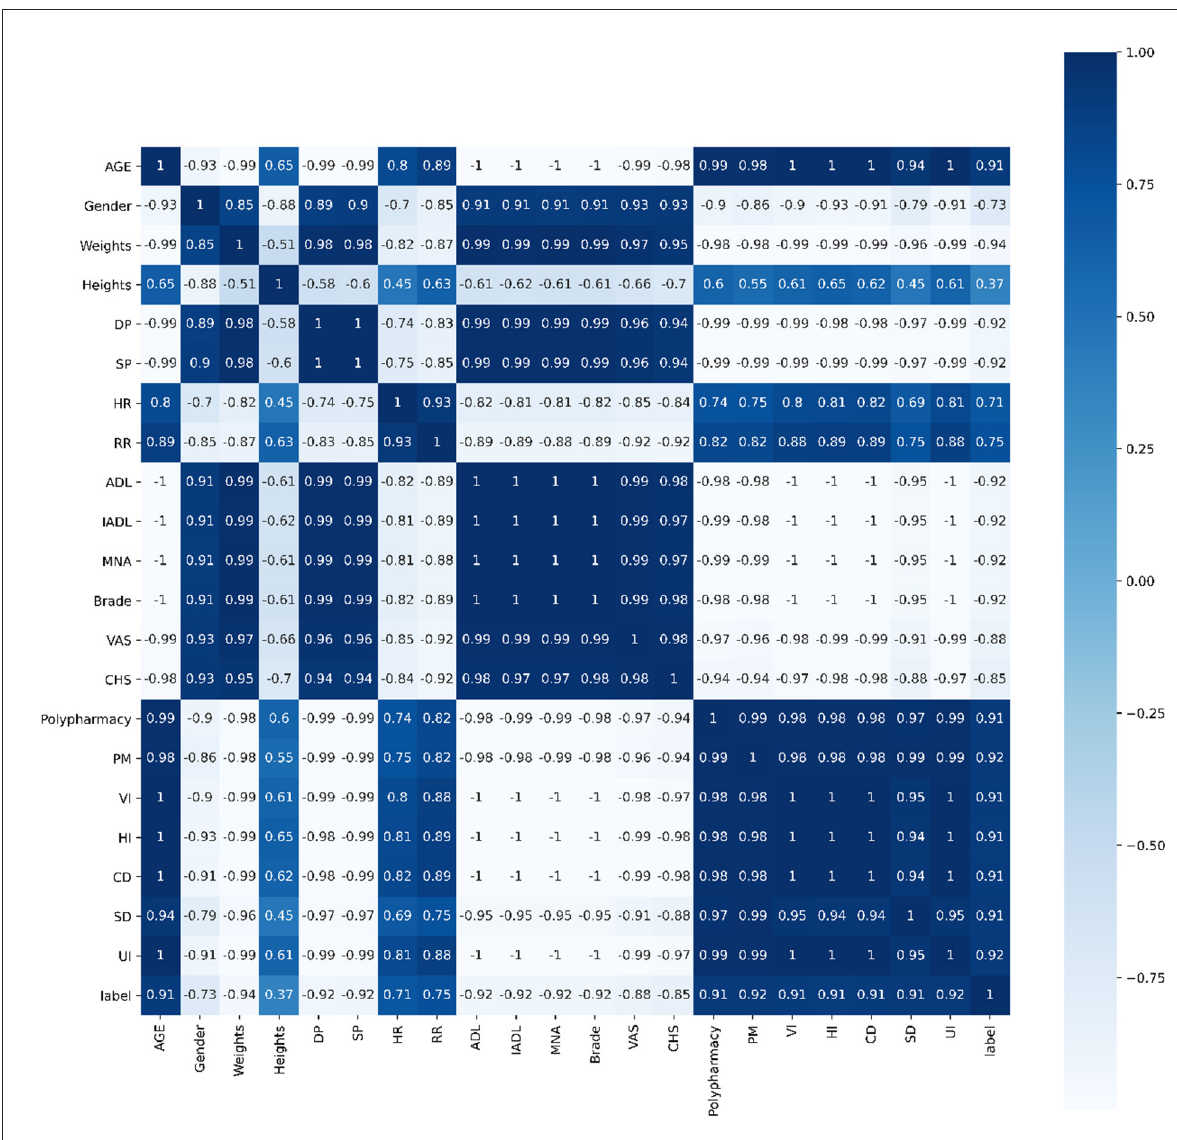
FIGURE8 Pearson’s correlation of all 21